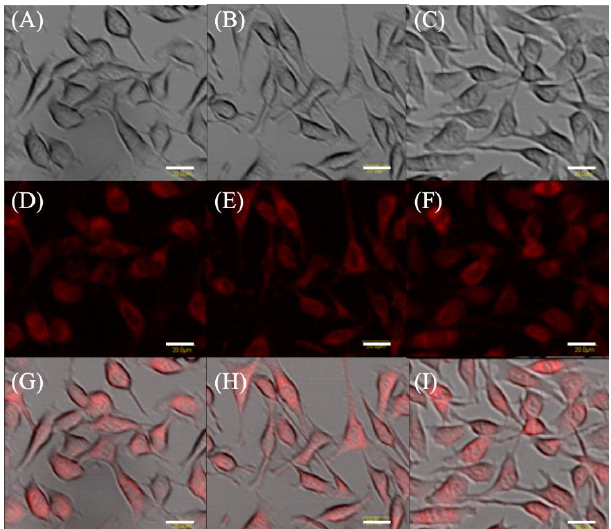
Figure 1. Protoporphyrin IX fluorescence in EMT-6. Cells were incubated with 1 mM 5-aminolevulinic acid (5-ALA) ( A , D , G ), and 1 mM 5-ALA plus concentrations of 7.8 µ M artesunate ( B , E , H ) or artemether ( C , F , I ) for 4 h. Transmission, fluorescence, and merged images of EMT-6. Upper panel ( A – C ): Transmitted light images. Middle panel ( D – F ): Fluorescence images. Lower panel ( G – I ): Merged images. Scale bar = 20 µ